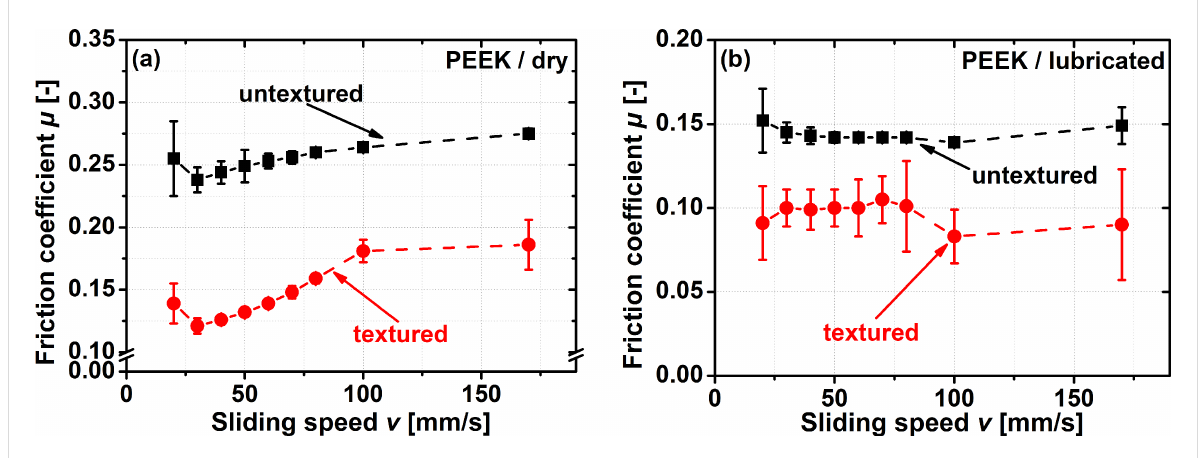
Figure 3: Stribeck curve-like pin-on-disc experiments for a variation in sliding speed from 20 to 170 mm/s for dry (a) and lubricated (b) steel-on- polymer contacts. The normal force was 2 N during all experiments.